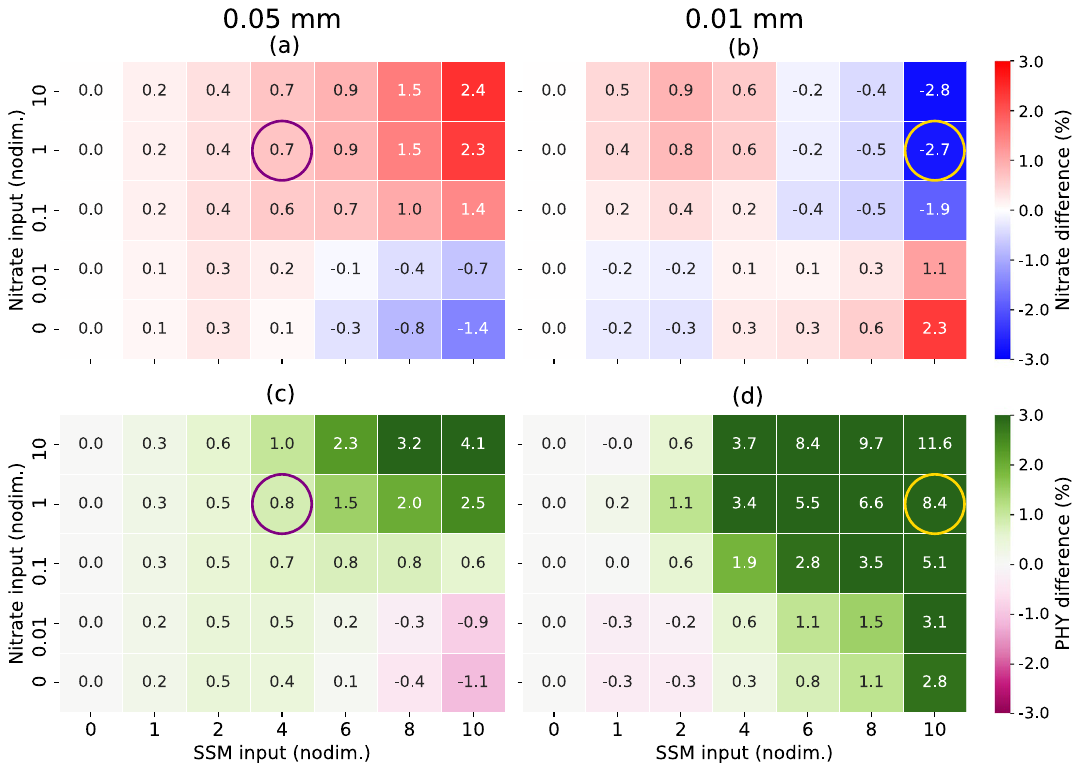
Figure 8. ( a , b ) Nutrients (nitrate) and ( c , d ) PHY (phytoplankton) differences from WOS in the surface (the top two layers) and river plume area (salinity ≤ 28.0) mean, in sensitivity experiments considering changes in SSM inputs (x-axes) and nitrate inputs (y-axes), when the river plume is sufficiently large (Sep. 17, 00:00 LT). Values of the x- and y-axes are normalized by those of STD. ( a , c ) Relatively large SSM diameter (0.05 mm) is likely to generate a hypopycnal situation. ( b , d ) Relatively small SSM diameter (0.01 mm) is likely to cause a hyperpycnal situation. Purple circles mark typical hypopycnal cases, yellow circles typical hyperpycnal